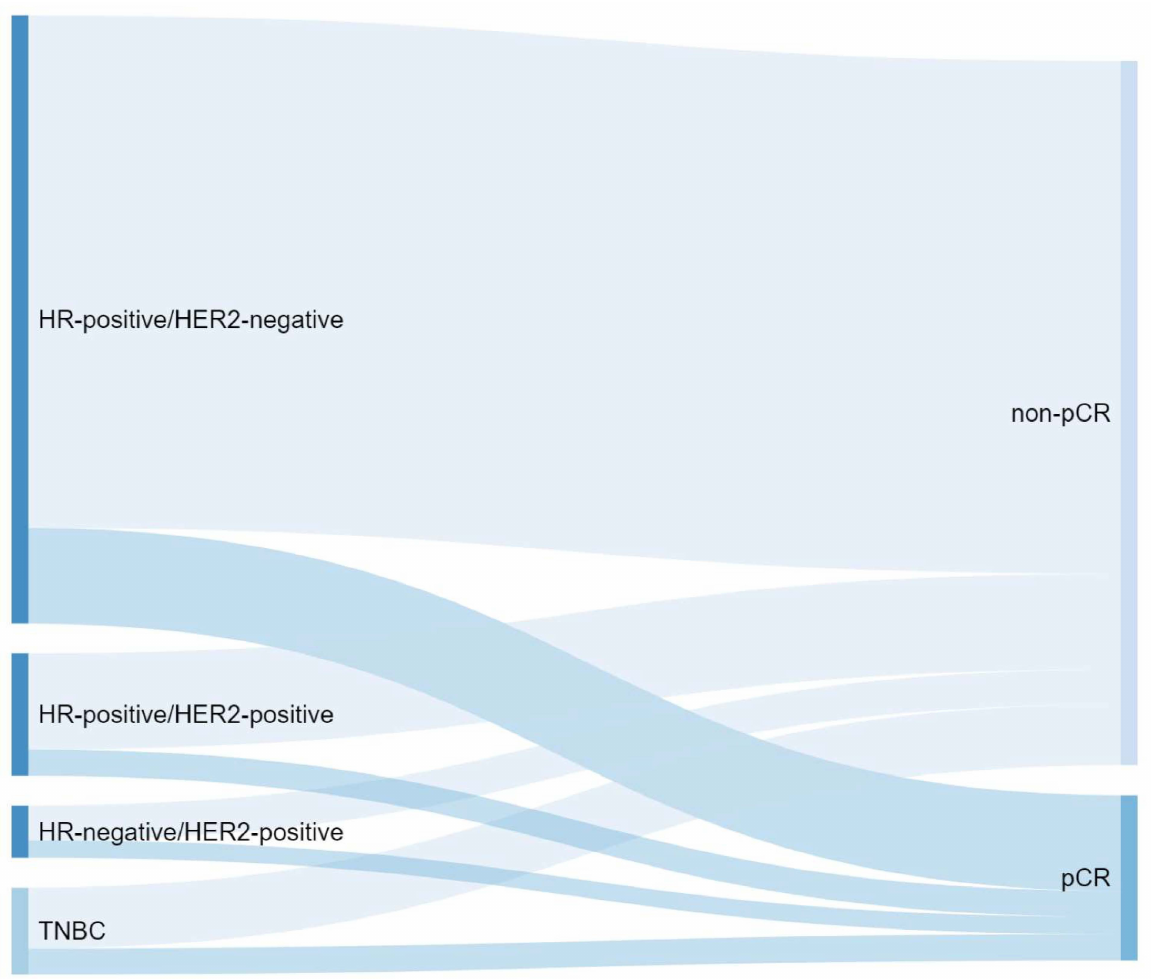
Figure 2. Proportion of pathological complete response (pCR) after neoadjuvant therapy according to breast cancer subtypes. HR-positive/HER2-negative (HR+/HER2 − ) is the most prevalent subtype in breast cancer, occurring in approximately 70% of patients, followed by HER2 − positive (HER2+) and TNBC subtypes (approximately 20% and 10%, respectively). Subtype-specific pCR rate are 8.3% in HR+/HER2 − , 18.7% in HER2+/HR+, 38.9% in HER2+/HR − and 31.1% in TNBC (original figure based on literature data, i.e., Houssami et al., Meta-analysis of the association of breast cancer subtype and pathologic complete response to neoadjuvant chemotherapy, Eur J Cancer 2012. doi: 10.1016/j.ejca.2012.05.023) [9]. Abbreviations: HR: hormonal receptors; TNBC: triple-negative breast cancer; pCR: pathological complete